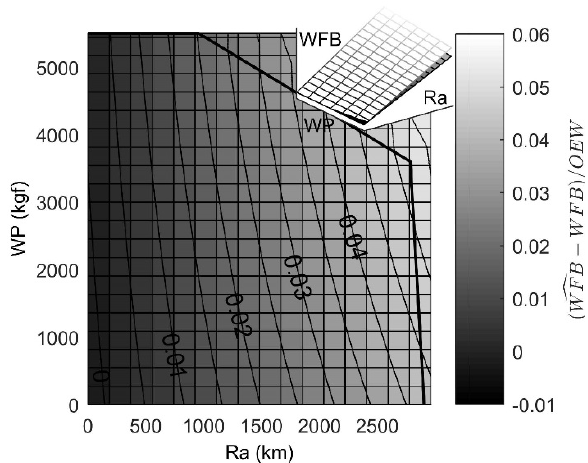
Figure 11. Relative error on the fuel consumed (WFB) between the predicted value and the actual value for the increasing altitude case on a validation sample. The thumbnail shows the actual unbracketed fuel consumption matrix in gray tones and the predicted WFB (cid:3555) -matrix in shade.